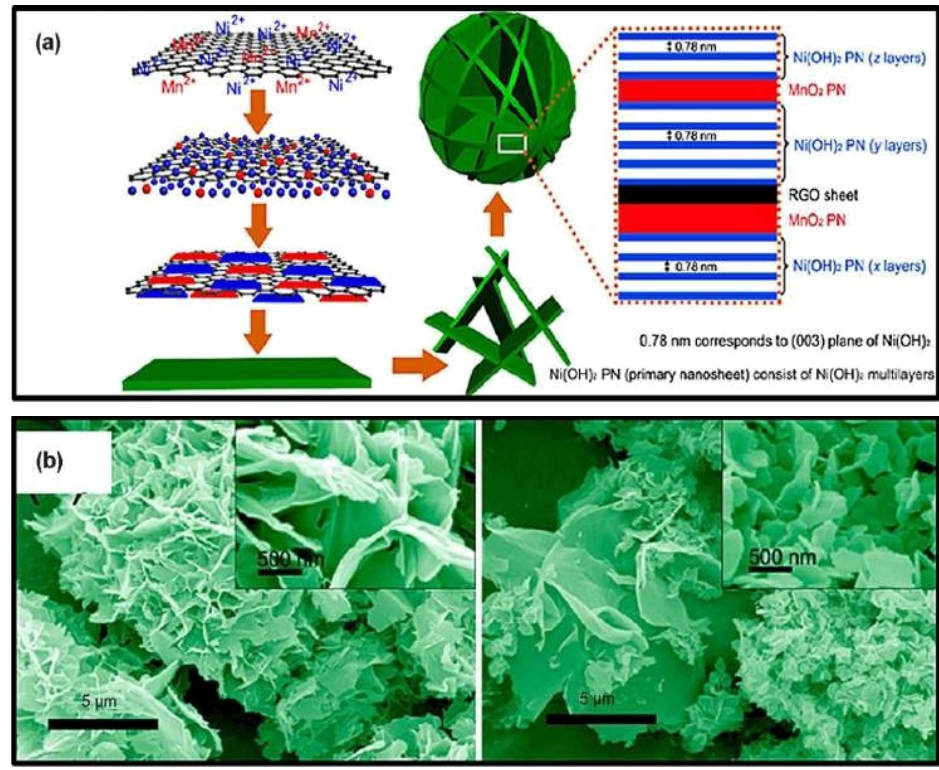
Figure 16. ( a ) A schematic depiction of a potential formation pathway for a Ni(OH)2-MnO2-rGO hybrid sphere, with ( b ) SEM results. Reproduced with permission from [91].